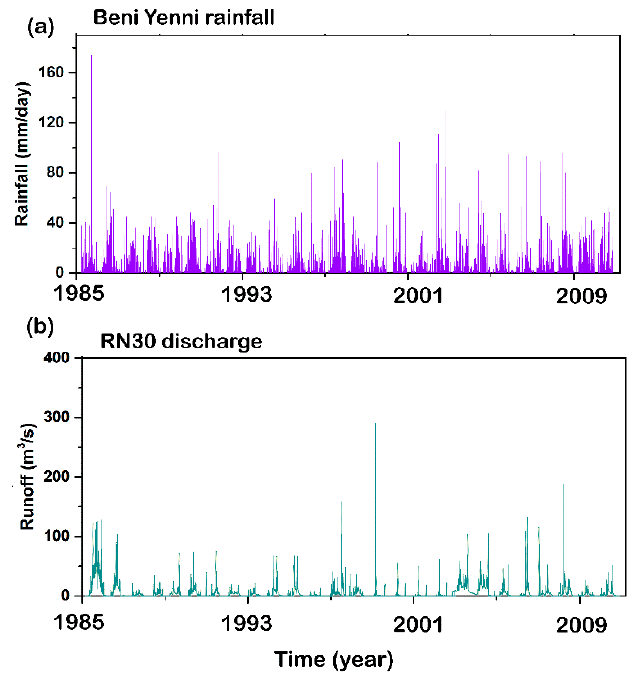
Figure 3. Representation of daily time series of rainfall (Ben Yenni station) and streamflow (RN30 station) in Aïssi River sub-basin (1985–2010).